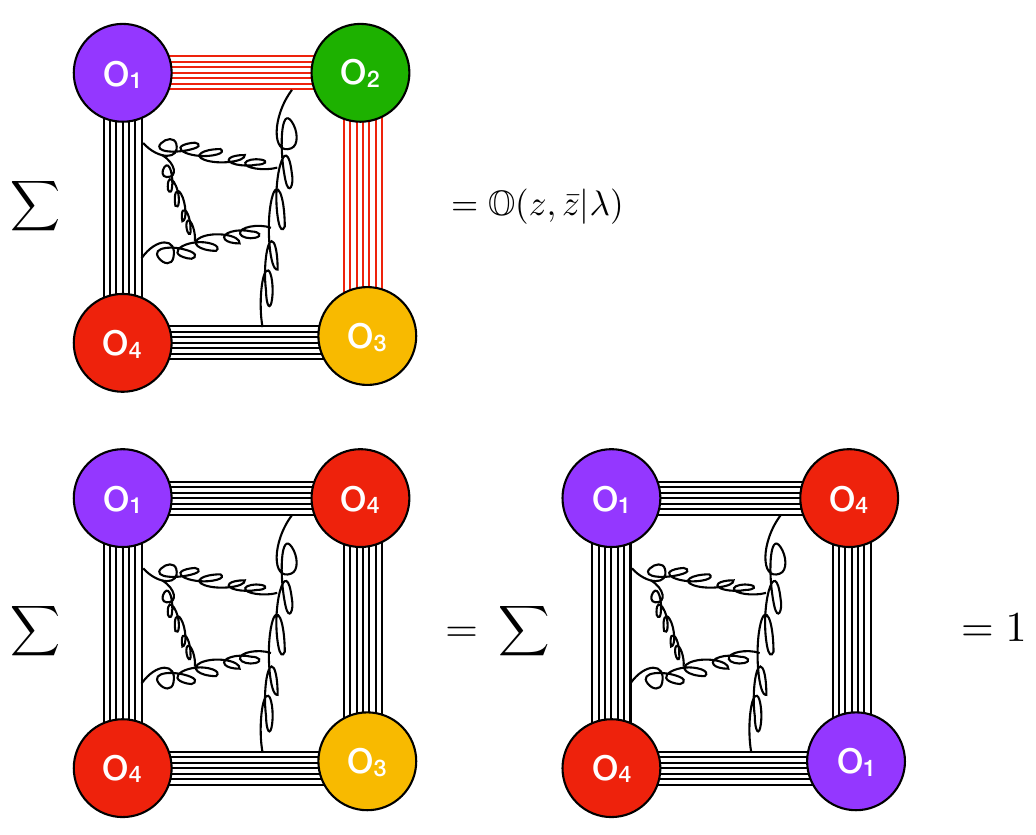
Figure 6 . The three types of squares all large- k skeleton graphs are made of, see (2.2). Squares can connect all four operators (top (cid:12)gure), and all such squares equal the non-trivial function O of the ’t Hooft coupling (cid:21) and the cross ratios parametrized by z and (cid:22) z . Squares may also only connect three operators (bottom left) or two operators (bottom right), such squares are protected by supersymmetry and hence do not receive loop